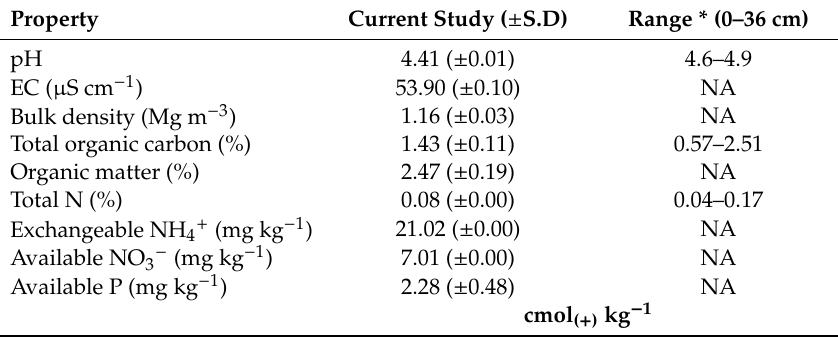
Table 1. Selected physical and chemical properties of Bekenu